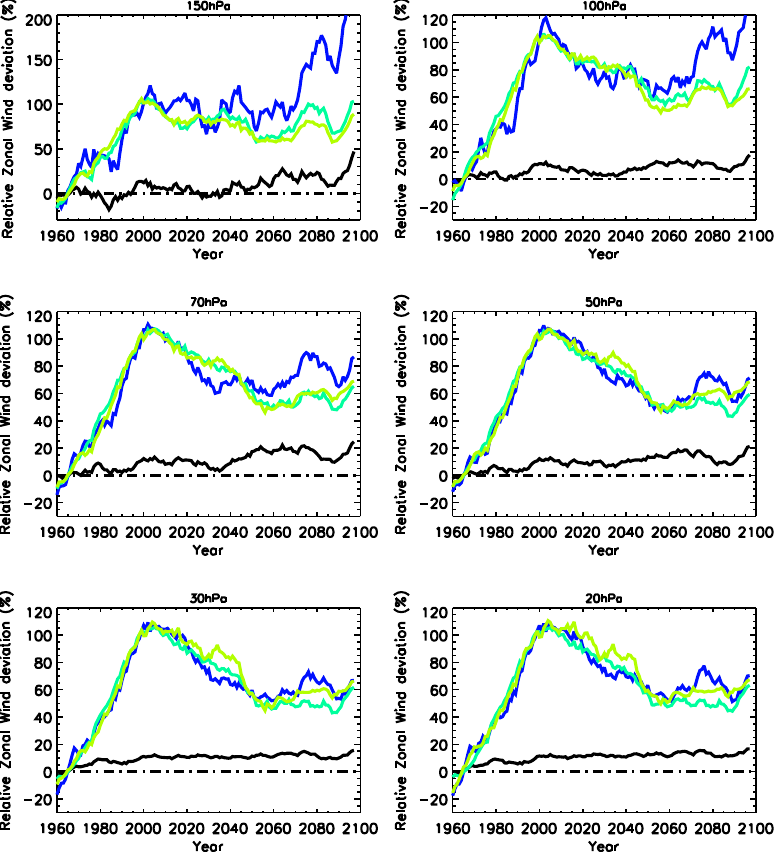
Fig. 8. Normalized time series of percent deviation of zonal mean zonal wind speed averaged over 50 ◦ –70 ◦ S. For full description see text. Figure 8. Normalized time series of percent deviation of zonal mean zonal wind speed The September wind data have been scaled, divided by 10 at all altitudes. Colors correspond to same months as in Fig. 5. averaged over 50º-70ºS. For full description see text. The September wind data have been scaled: divided by 10 at all altitudes. Colors correspond to same months as in Figure 5. percentage deviation, δ , as shown in Fig. 8. This